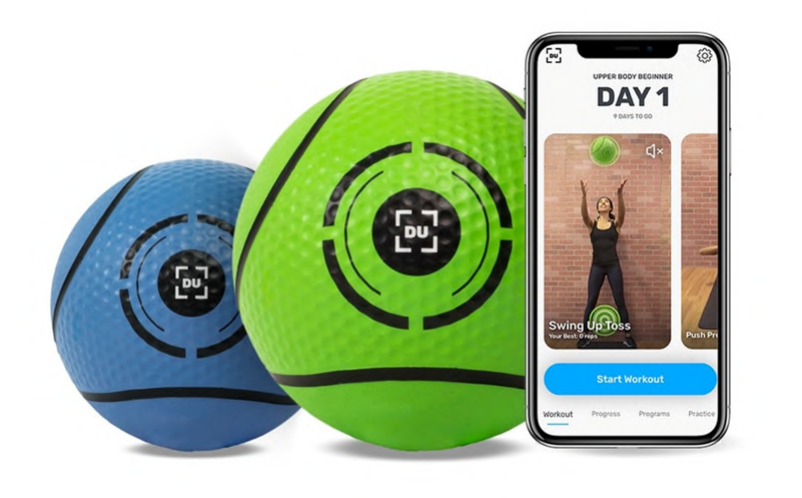
Figure 5: DribbleUp: Smart Strength Ball [38].